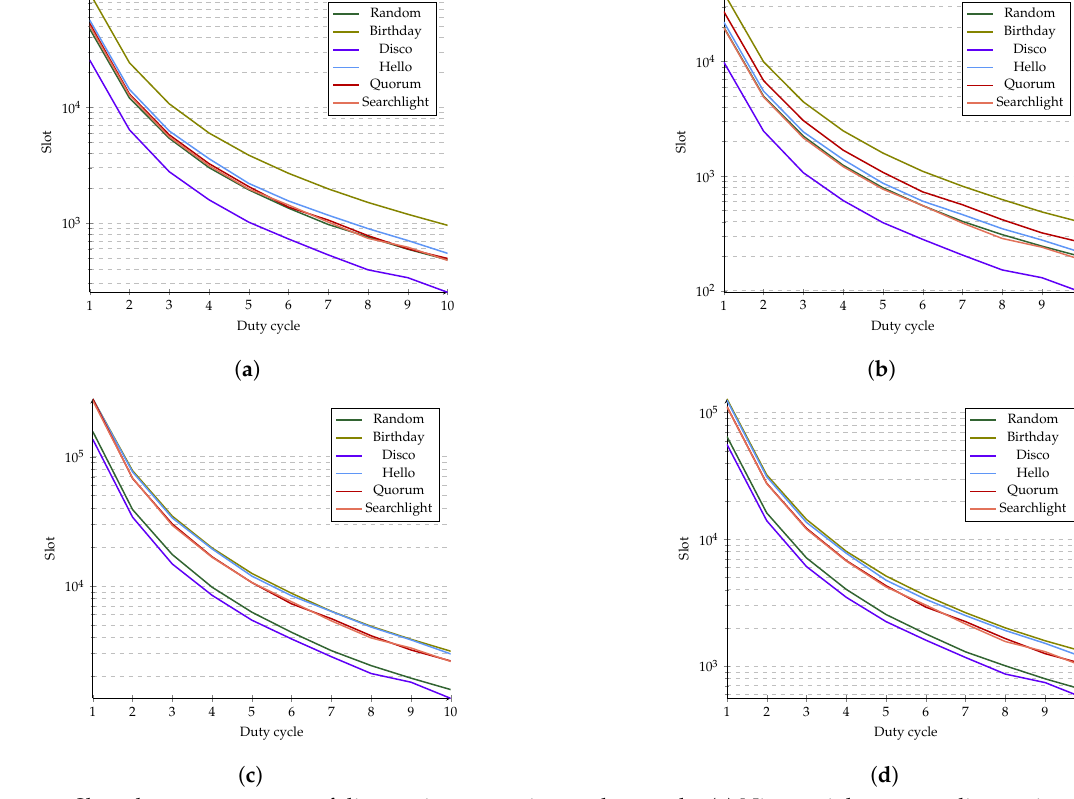
Figure 16. Slot where a percentage of discoveries occur given a duty cycle. ( a ) Ninety-eight percent discoveries, 10% error. ( b ) Eighty percent discoveries, 10% error. ( c ) Ninety-eight percent discoveries, 50% error. ( d ) Eighty percent discoveries, 50%